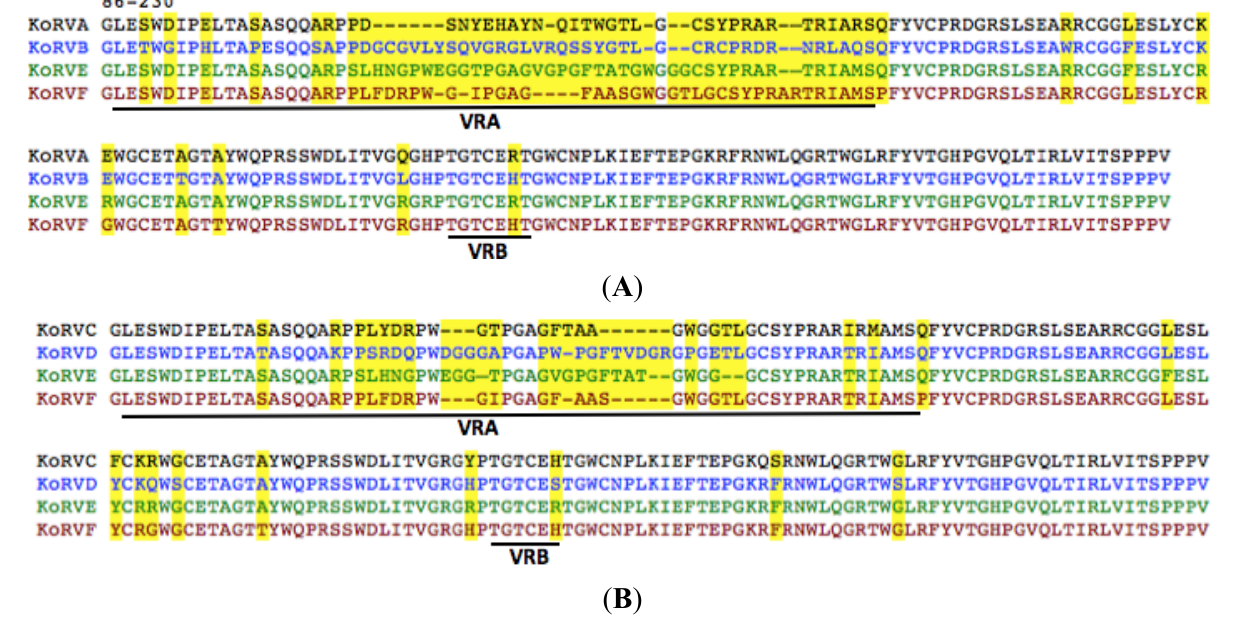
Figure 3. ( A ) KoRV-A, B, E, and F envelope proteins differ mainly in the VRA region. Alignment of the amino terminus of KoRV-A,-B,-E and -F (corresponding to residues 86–230 of KoRV-A) envelope proteins. Residues that differ among this envelope segment are highlighted in yellow; ( B ) Predicted KoRV-F residues comprising the amino terminal region of the envelope protein aligned to the corresponding regions of KoRV-C, D, and E and F residues (residue numbers correspond to KoRV-A envelope residues 86–230). The putative VRA and VRB regions are underlined with residues that differ among the four isolates highlighted in